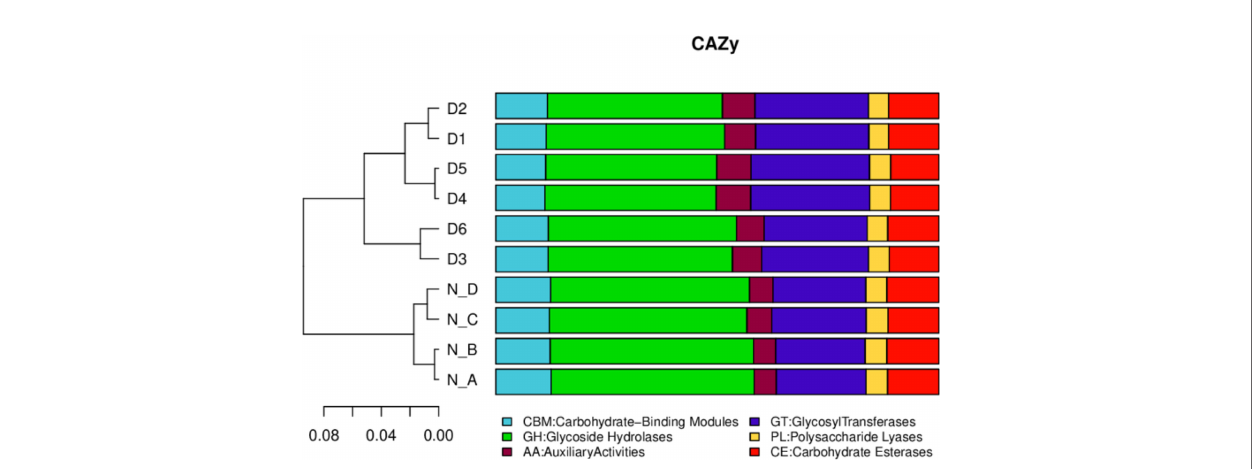
FIGURE 8 | The functional relative abundance analysis. CAZy. D1, D2, D3, D4, D5, and D6 represent the diarrheal samples; N_A, N_B, N_C, and N_D represent the normal